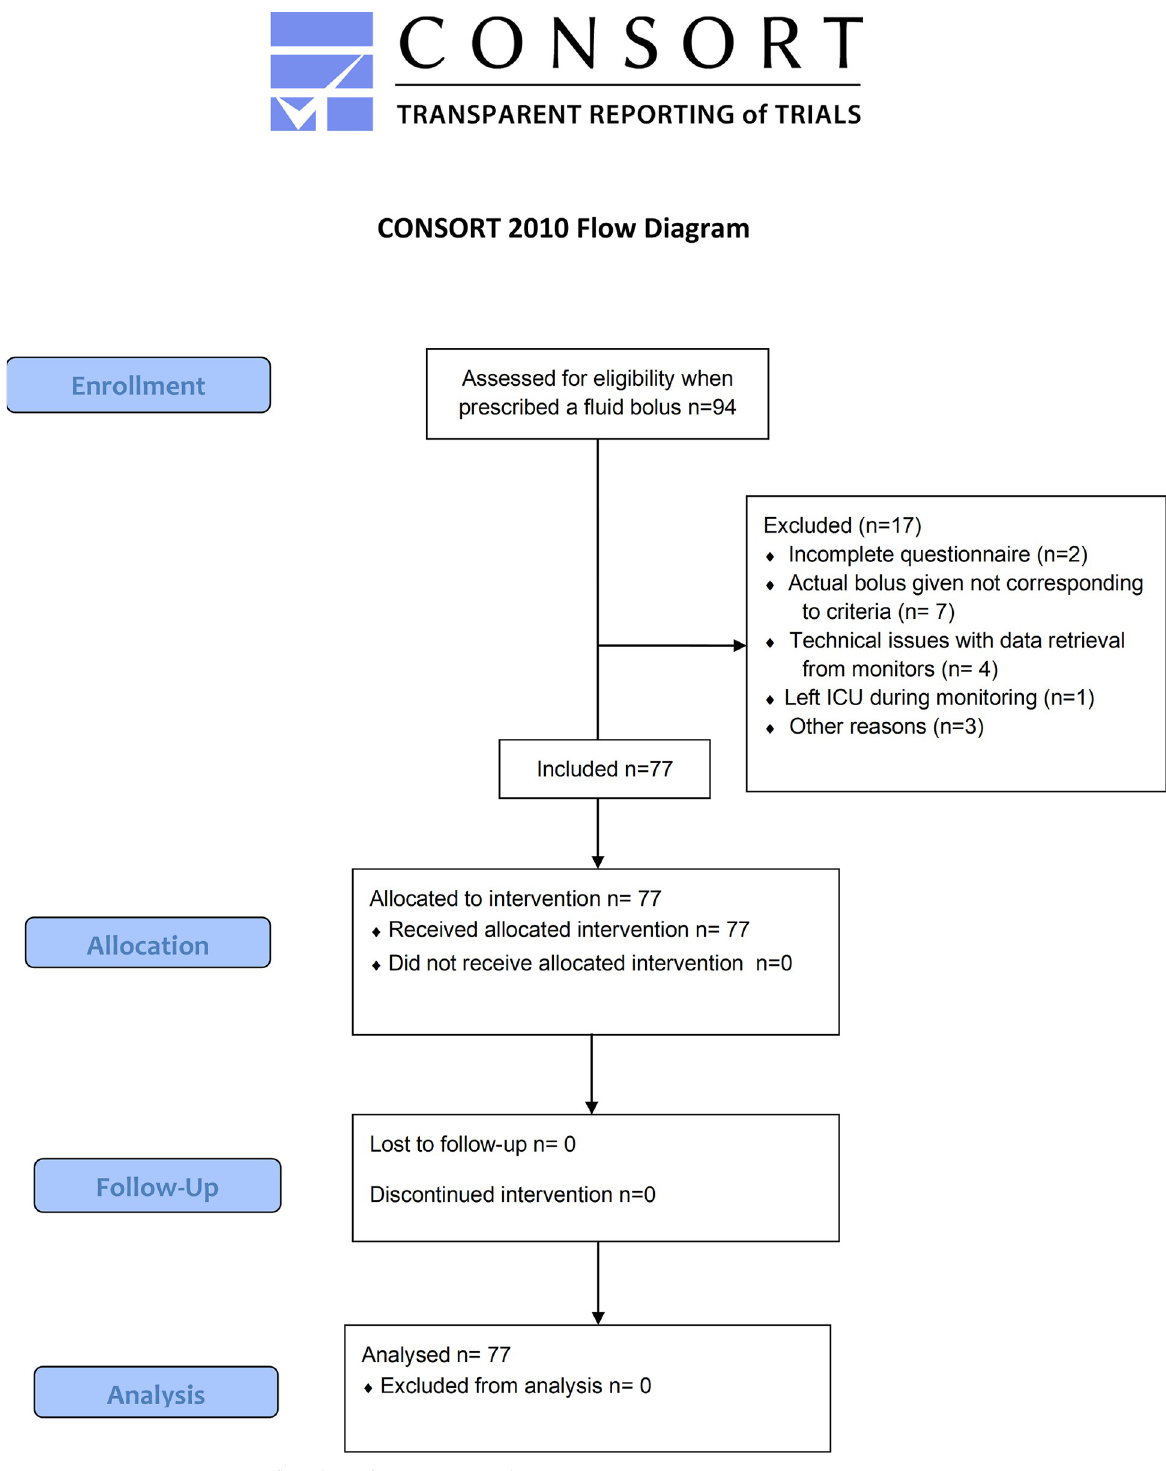
Fig 1. Study flow chart. Consort flow chart of patients screened.